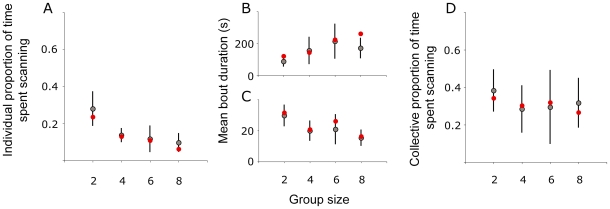
Experimental and predicted patterns of vigilance as group size increases.Figure 2 represents both the experimental (grey circles: mean±CI95%) and simulated (red circles) dynamic outcomes as a function of group size. Figure 2A shows the average proportion of time an individual spent scanning. Figure 2B and 2C represent the average duration of foraging and scanning bouts, respectively. Figure 2D shows the average proportion of time where at least one individual in the group is scanning (also referred as collective vigilance).